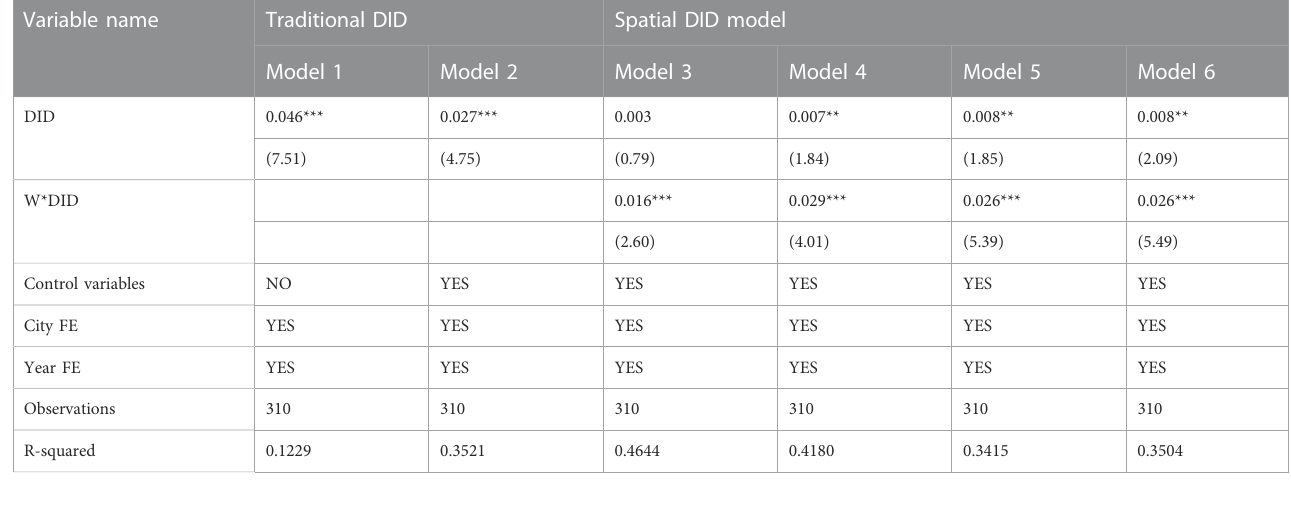
TABLE 8 Regression results for the spatial difference-in-differences.